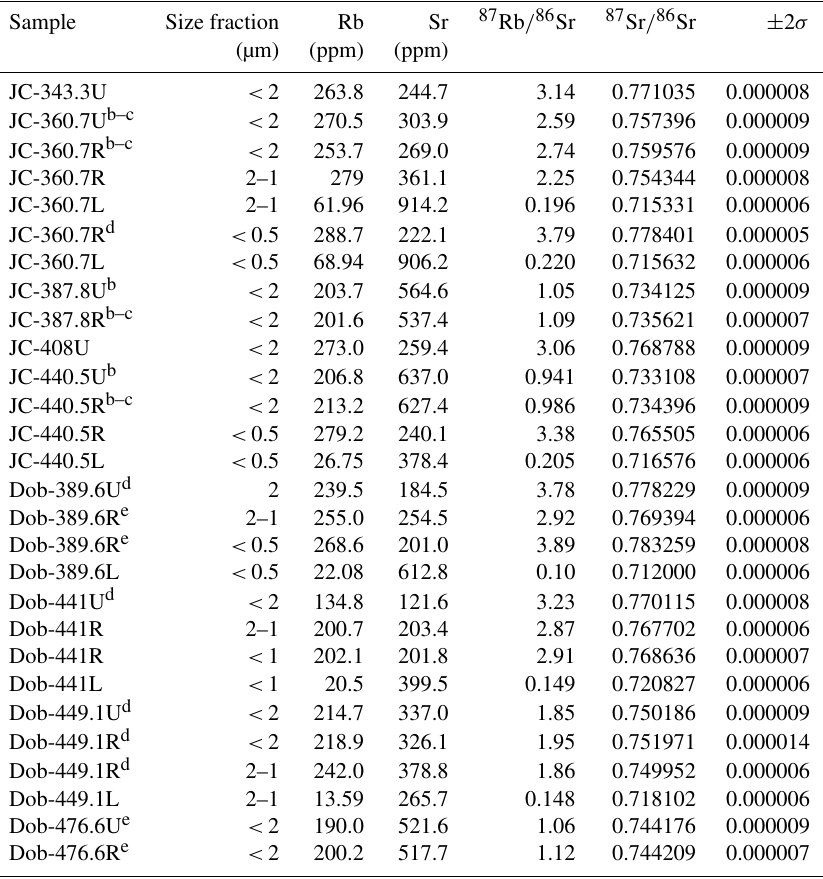
Table 3. 87 Rb– 86 Sr data for the untreated (U) and acid leached residues (R) of different clay fractions from the Millungera Basin fault gouges.